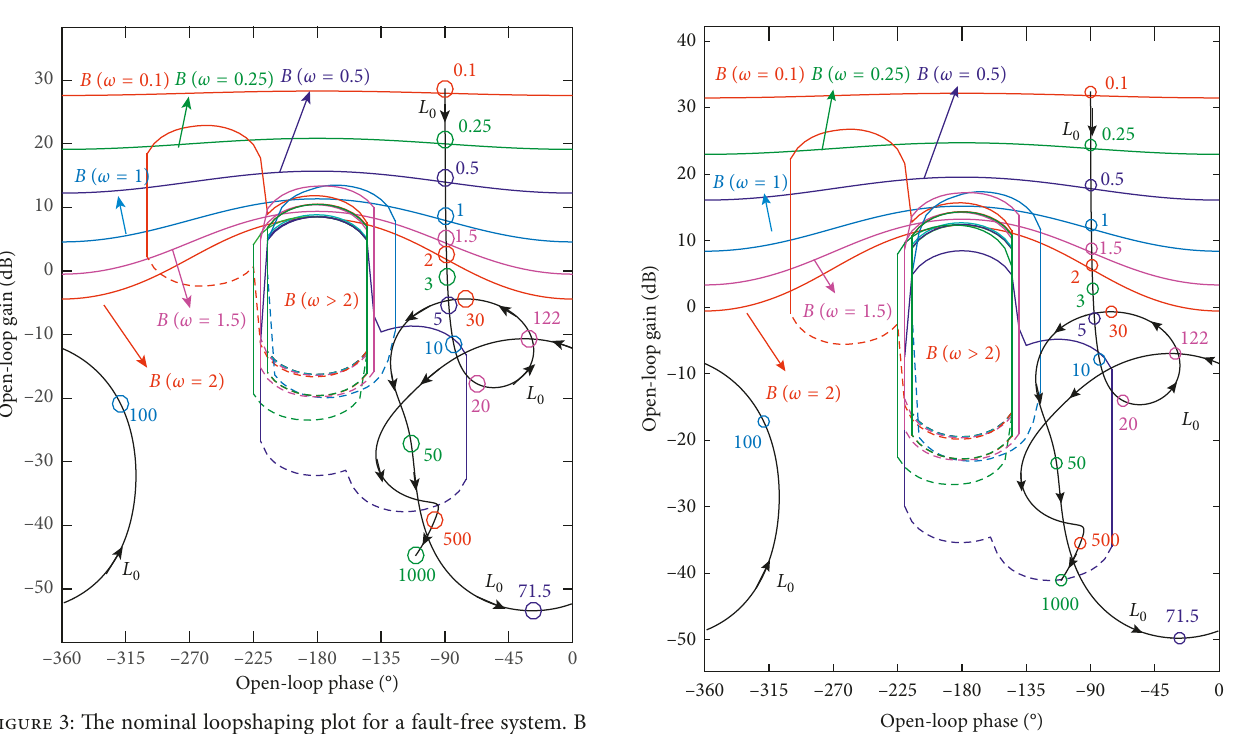
4: The nominal loopshaping plot for a faulty system. The bound at each design frequency ω is represented as B ( ω